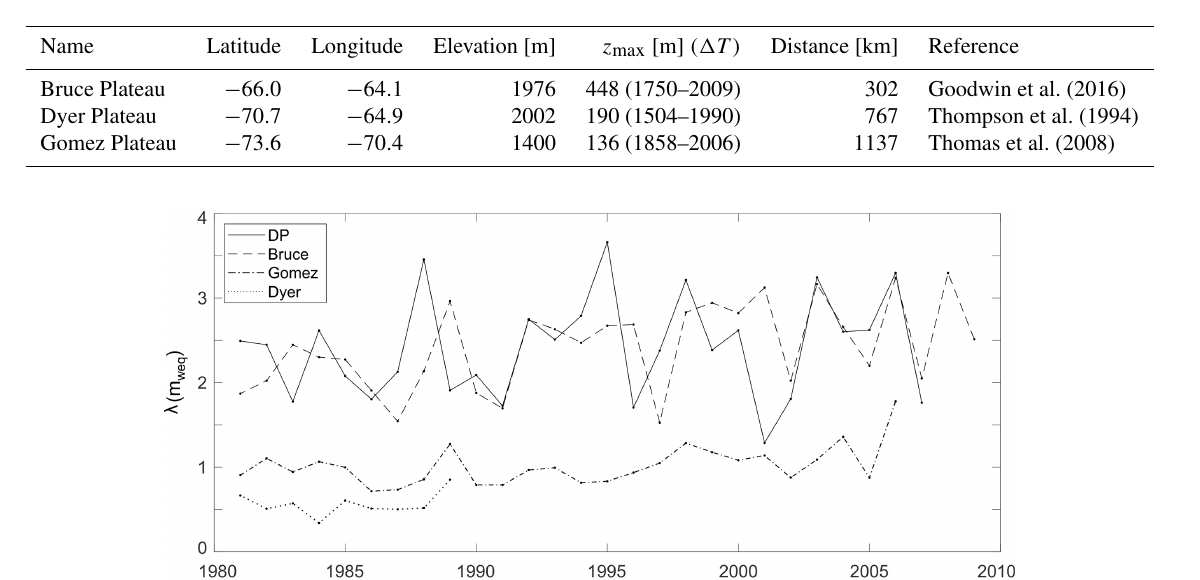
Table 1. Location of third-party ice cores sites on the Antarctic Peninsula with their distances to the DP ice core. z max is the maximum depth, and the period (cid:49)T , in years, is shown in parentheses.